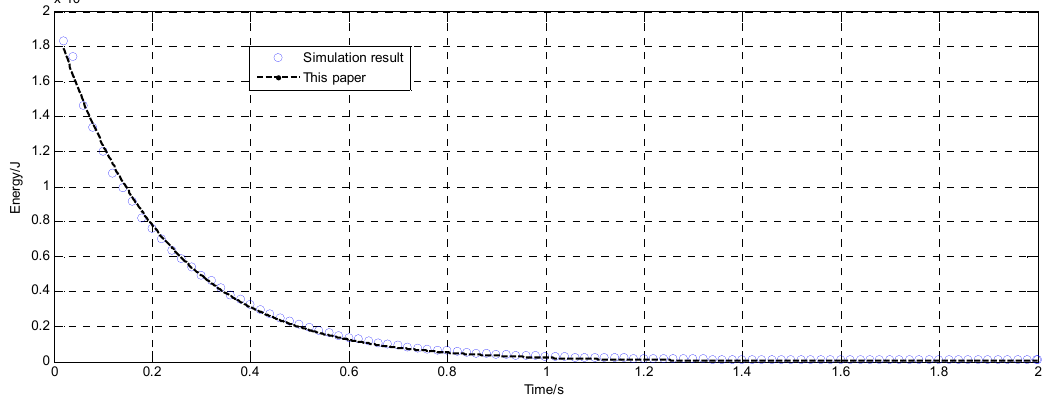
ρ ρ = 10 ton/m 3 . = 10 ton/m 3 .